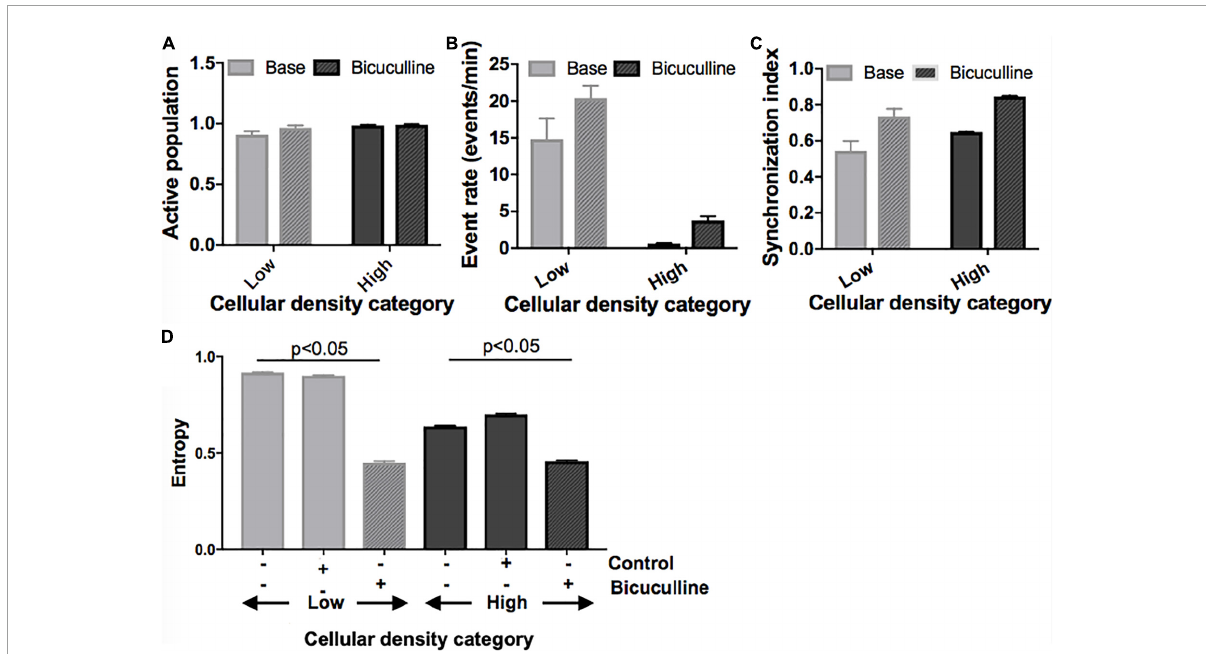
FIGURE7 Activity response to alterations in excitatory/inhibitory balance in neuronal islands of different cellular densities. (A–C) Solid fill bars. Summary activity statistics of islands reveal that, s before, event rate at baseline was dependent on cellular density: low density islands showed significantly higher rates of activity than high density islands (two-way ANOVA p < 0.05 for “cellular density” factor). Synchronization index also showed a trend of higher synchronization at higher island density, but was not significant, likely due to the small sample size. (A–C) Patterned fill bars. Removal of inhibitory synaptic transmission after treatment with Bicuculline, a GABA A inhibitor ( n = 11), recruited the remaining non-active population of neurons, and significantly increased island activity rate and synchronization level (two-way ANOVA p < 0.01 for “drug” factor). This effect was uniform across islands density groups (“density” × “drug” interaction term not significant). (D) The addition of Bicuculline also significantly decreased entropy compared to baseline values and to the control (adding inert MEM). This effect was seen in both low- and high-density islands (two-way ANOVA p < 0.05 for “drug”